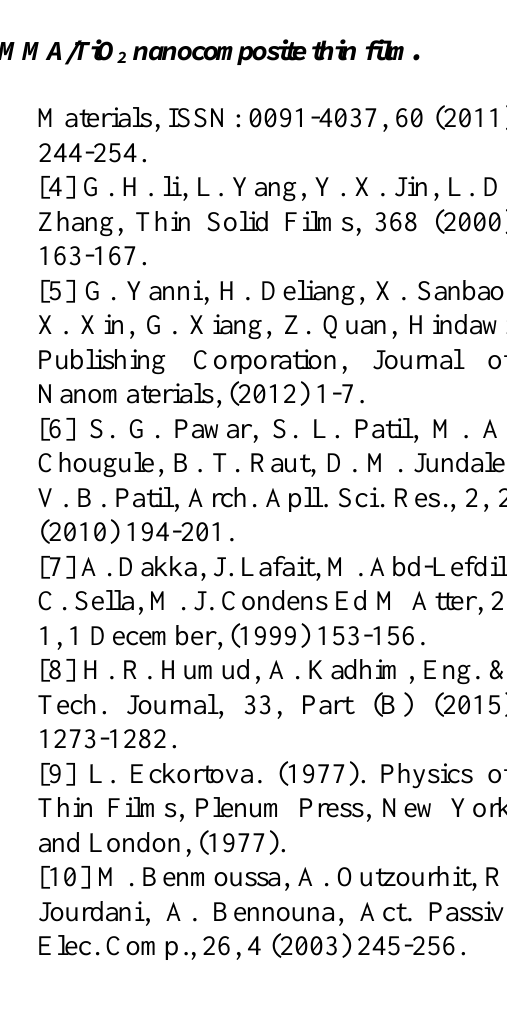
Fig. 4: X-ray diffraction pattern for PMMA/TiO